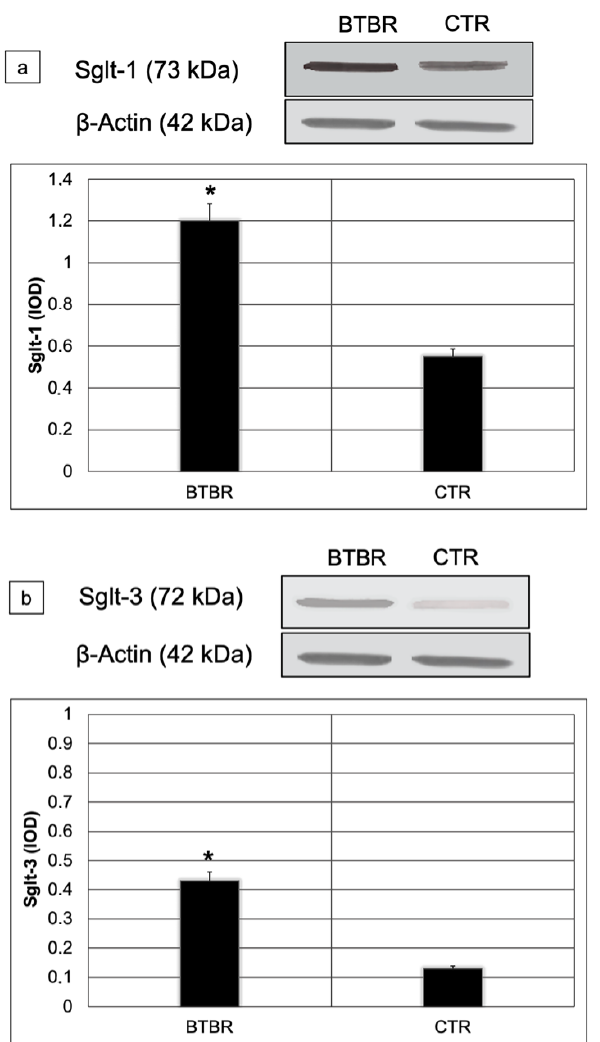
Figure 6. Representative blot and densitometric analysis of Sglt-1 ( a ) and Sglt-3 ( b ) proteins levels in the small intestine of studied groups. Data are presented as mean ± SD. * p < 0.01 vs. CTR mice.